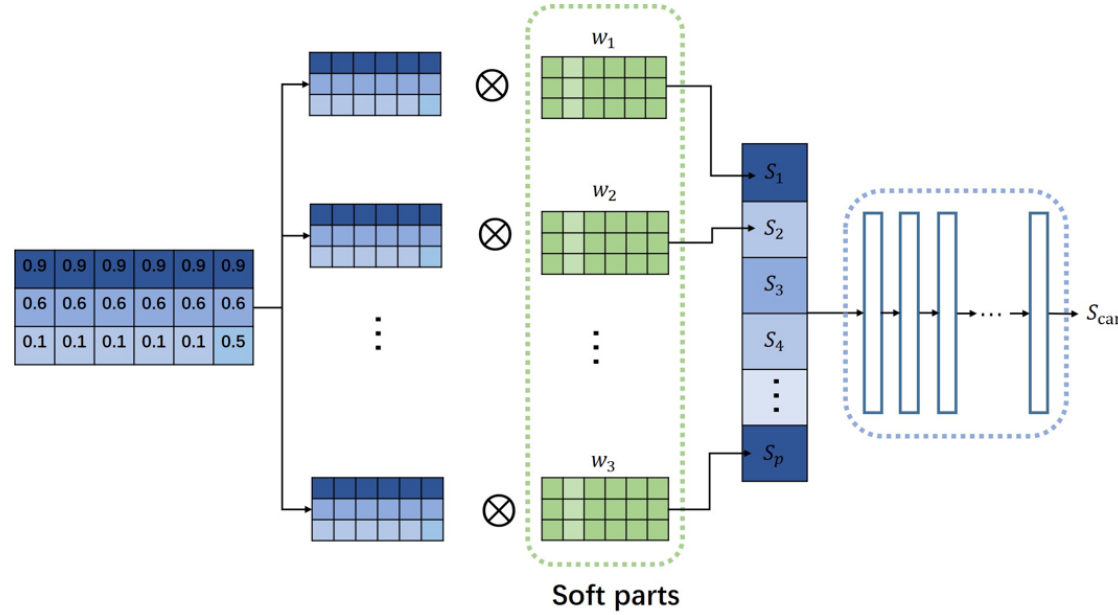
Figure 5. Structure of part-aware refinement